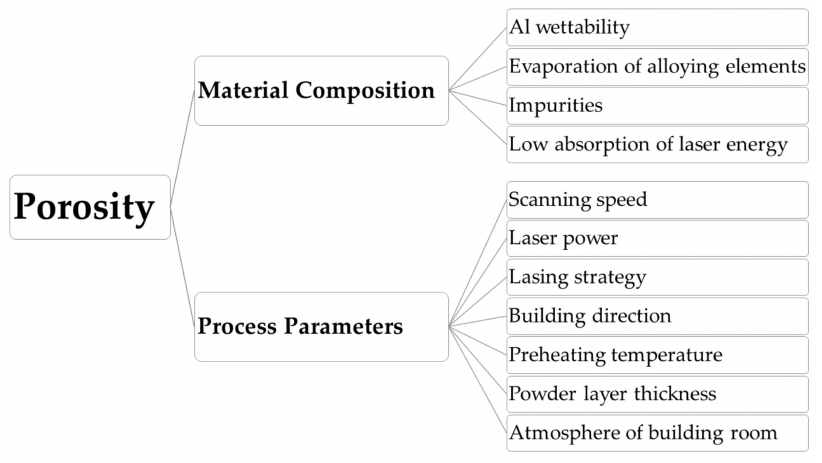
Figure 4. Causes of porosity in the AM process of Al